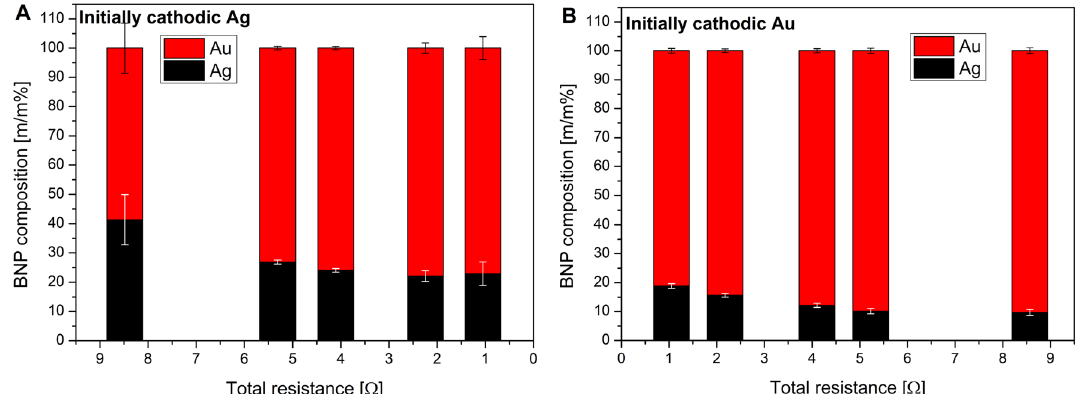
Figure 3. Composition of the generated Au/Ag BNPs as a function of the total circuit resistance when the initially cathodic electrode is silver ( A ) or gold ( B